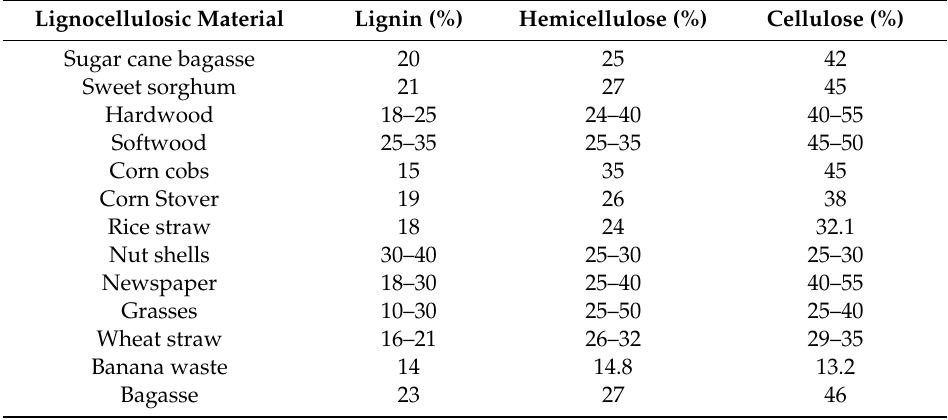
Table 2. Typical component analysis of some plant biomass samples (adapted from [73,74]).